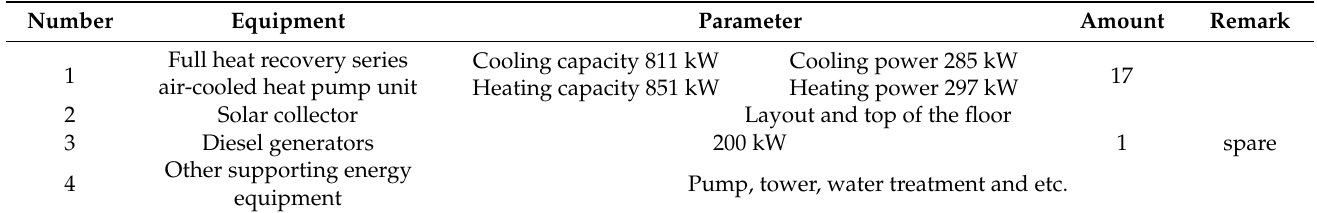
Table A4. Solar air source heat pump system main equipment.